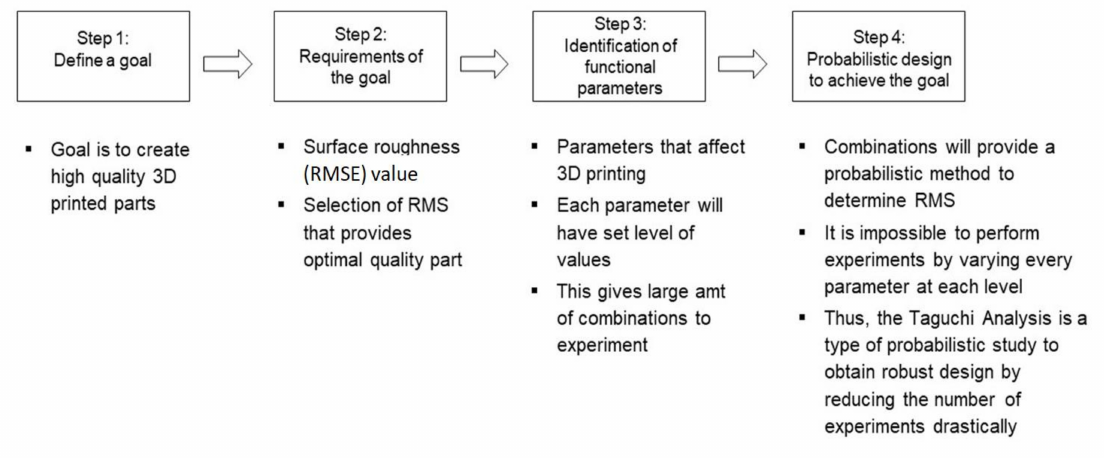
Figure 8. Steps for developing a robust